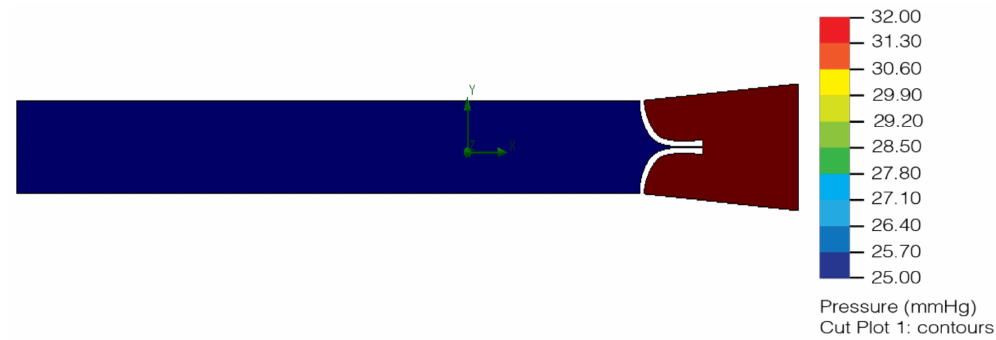
Figure 14. Liquid flow with pressure in closed valve correctly preventing the return of lymph (2020). In the area with the largest diameter, the pressure value is greater than the value at the outlet where the diameter is smaller. This pressure difference makes it possible for there to be a flow of lymph, where it goes from an area of higher pressure to one of lower pressure. (Figures 15 and 16). Final lymphatic vessel design (Figure 17).